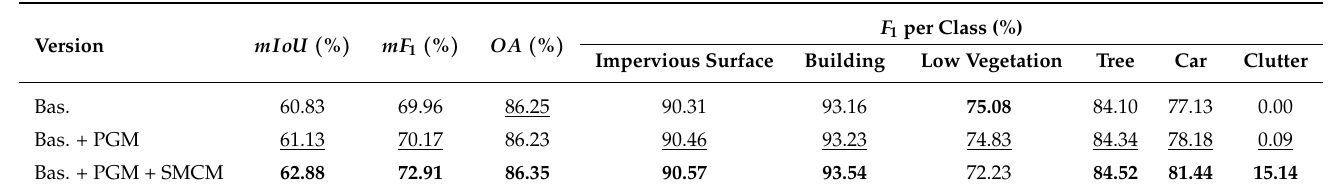
Table 5. The results of ablation experiments on the ISPRS Vaihingen dataset. The best results are highlighted in bold , and the second-best is marked in